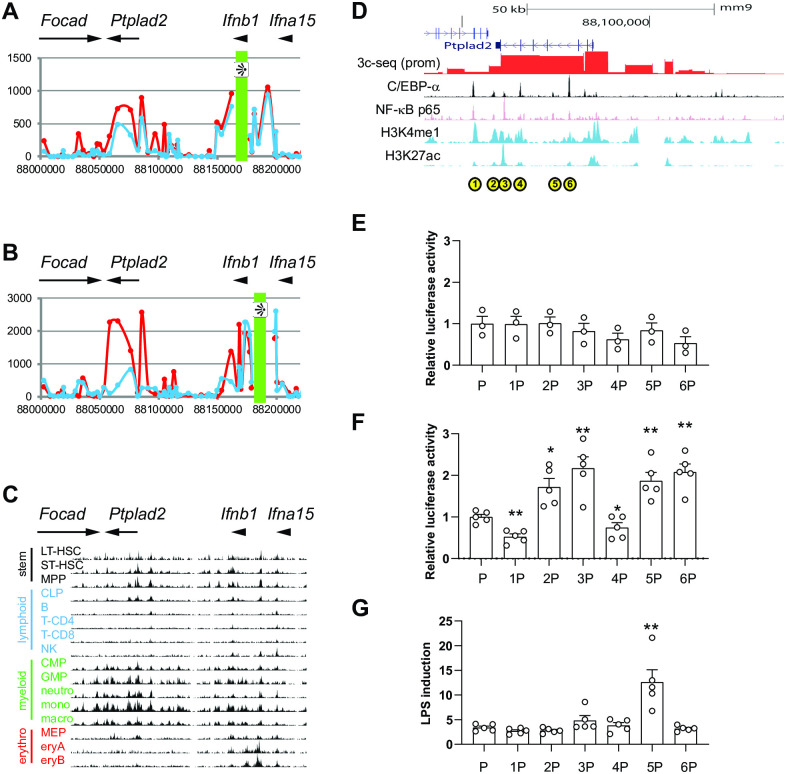
The murine Ifnb1 gene loops to a myeloid super-enhancer in Ptplad2.(A and B) 3c-seq analysis of the Ptplad2/Ifnb1 locus using (A) Ifnb1 or (B) the ICE regulatory region as viewpoints in activated WT (blue line) or Trim33-/- (red line) macrophages. Genes are indicated above the graph, and position on chromosome 4 (mouse genome version mm9) is indicated below the graph. (C) Normalized signal from H3K4me1 ChIP-seq experiments performed in hematopoietic sub-populations (B: B lymphocytes, CLP: common lymphoid progenitors, CMP: common myeloid progenitors, eryA: erythroblasts A, eryB: erythroblasts B, GMP: granulocyte monocyte progenitors, LT-HSC: long term hematopoietic stem cells, macro: macrophages, MEP: megakaryocyte erythrocyte progenitors, mono: monocytes, MPP: multipotent progenitors, neutron: neutrophils, NK: natural killer cells, ST-HSC: short term hematopoietic stem cells, T-CD4: CD4+ T lymphocytes, T-CD8: CD8+ T lymphocytes). Data from [40]. (D) Signal from ChIP-seq experiments targeting different transcription factors and histone marks over the Ptplad2 gene. The results of the 3C-seq experiment from the Ifnb1 promoter viewpoint is shown in red. Identified enhancers are indicated with yellow circles, and numbered. Data from [41] (C/EBPα), [42] (NF-κB p65), and [43] (H3K4me1 and H3K27ac). (E) Plasmids encoding firefly luciferase under the control of the Ifnb1 promoter (P) flanked or not with the enhancers identified above, each labelled with its number, were transfected into NIH3T3 cells together with a plasmid coding for Renilla luciferase under the CMV promoter. After 30 hrs, luciferase levels were measured. Results are expressed as the ratio of firefly to Renilla luciferase, normalized to the mean value of P. (F) Plasmids encoding firefly luciferase under the control of the Ifnb1 promoter (P) flanked or not with the enhancers identified above, each labelled with its number, were transfected into RAW264.7 cells together with a plasmid coding for NanoLuc luciferase under the thymidine kinase promoter. After 30 hrs, luciferase levels were measured. Results are expressed as the ratio of firefly to NanoLuc luciferase, normalized to the mean value of P. (G) Same experiment as in F, except that RAW264.7 cells were treated or not with 100 ng/ml LPS for the last 8 hrs. Results are expressed as the ratio of relative luciferase activity between LPS treated versus non-treated cells. For (E), (F), and (G), results are presented as mean ± s.e.m with open circles showing individual values, each in triplicate (n = 3 to 5). *: p<0.05; **: p<0.01 (two-sided ratio paired t test).